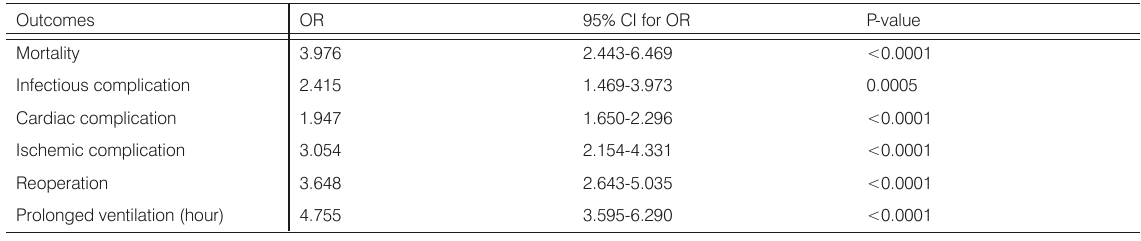
Table 4. Homologous blood transfusion effect on mortality and morbidity in Multivariable logistic regression analysis adjusted for